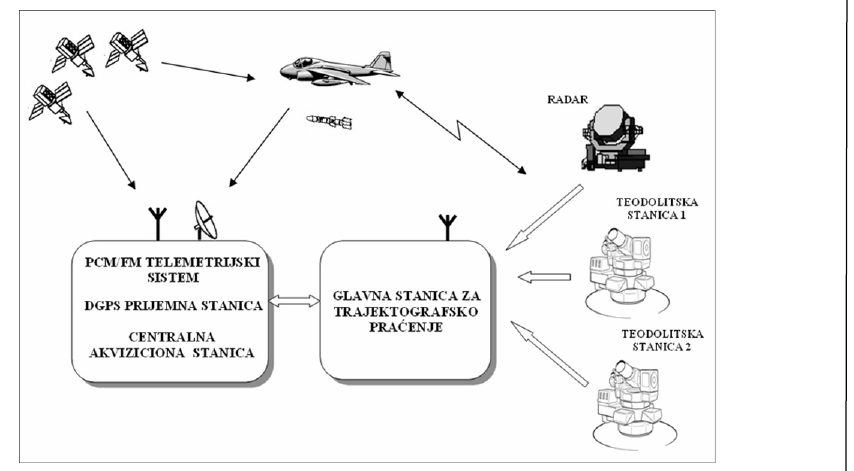
Figure 12 – Scheme of the arrangement of units (telemetry and theodolites) during tests (Arhiv Vazduhoplovnog opitnog centra, 2016) Рисунок 12 – Блок - схема сбора данных ( телеметрия и теодолит ) во время испытаний (Arhiv Vazduhoplovnog opitnog centra, 2016) Слика 12 – Шема распореда јединица ( телеметрија и теодолити ) у току испитивања (Arhiv Vazduhoplovnog opitnog centra,